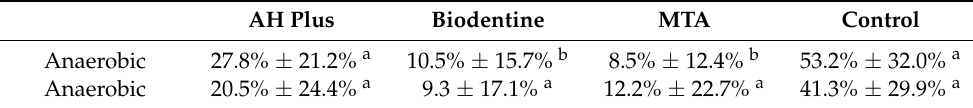
Table 1. The distribution of aerobic and anaerobic microorganisms in relation to the slab surface area. The means and standard deviations are depicted, and statistically significant differences are indicated with superscript